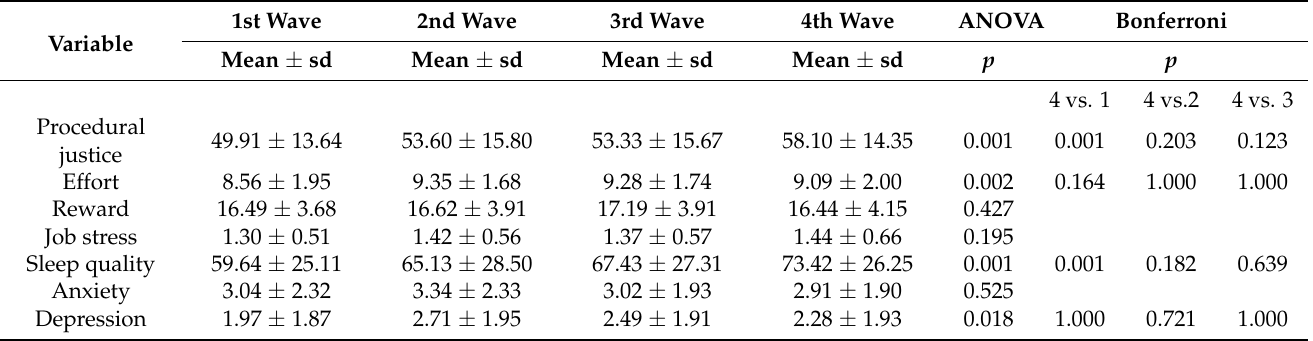
Table 4. Mental health indicators (perceived justice, occupational stress, sleep quality, anxiety, depression) in anesthesiologists during the COVID-19 pandemic waves.